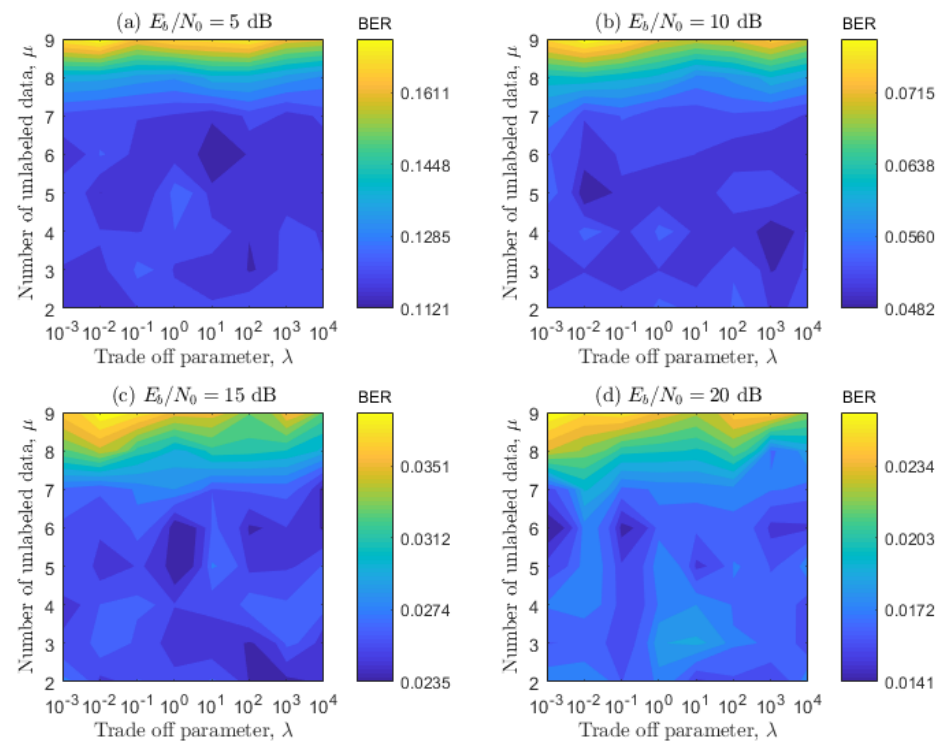
Figure 11. BER contour plot of λ and µ for different E b / N 0 values and system configuration